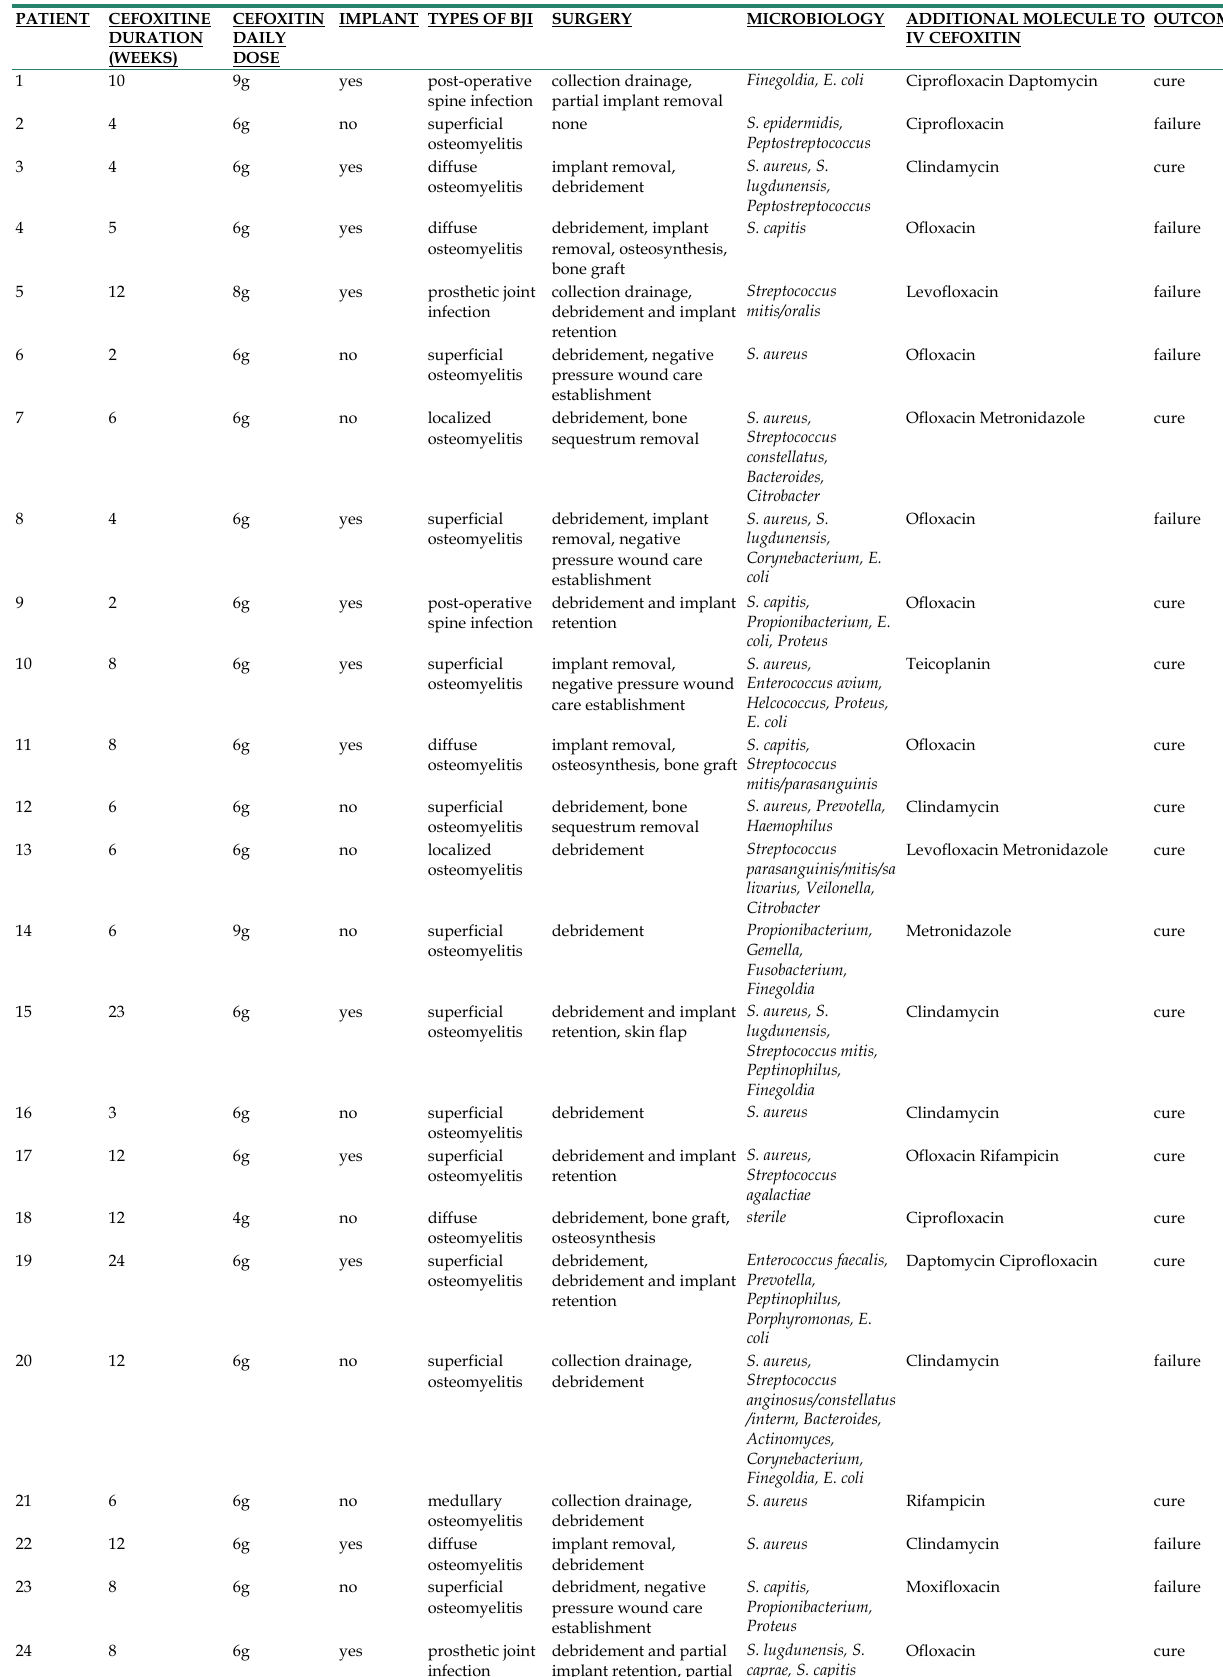
Table 1. Main characteristics of the 33 BJI PATIENT CEFOXITINE